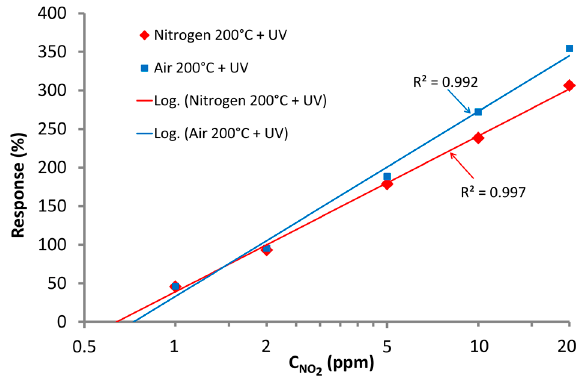
Figure 11. Representative sensor calibration curves for 200 °C with UV activation in air and nitrogen conditions.